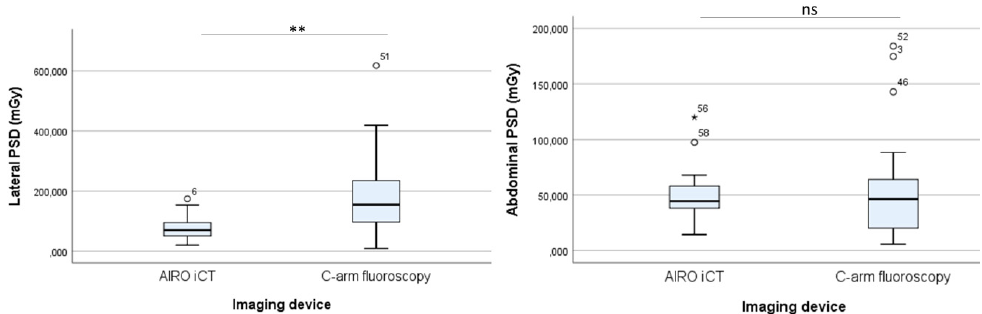
Figure 7. Peak skin dose (PSD) of the patient during an MI-PLIF procedure. ( a ) The lateral peak skin dose of the patient (mGy) compared between surgeries assisted by iCT ( n = 24) or C-arm fluoroscopy ( n = 27). ( b ) The abdominal peak skin dose of the patient (mGv) compared between surgeries assisted by iCT ( n = 24) or C-arm fluoroscopy ( n = 28). Extreme values are marked as “ ✩ ” and outliers are marked as “°” on the boxplot. Significance ( p < 0.01) is indicated with “**” above the two boxplots on figure 7a and non-significance is indicate with “ns” above the two boxplots on figure 7b.